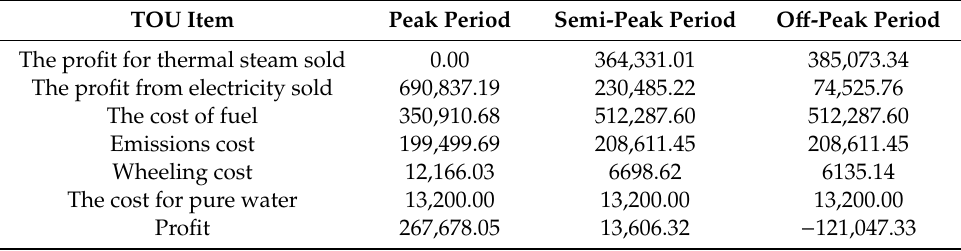
Table 7. Profit analysis of cogeneration systems at di ff erent TOU intervals. Unit: NT$ / H.